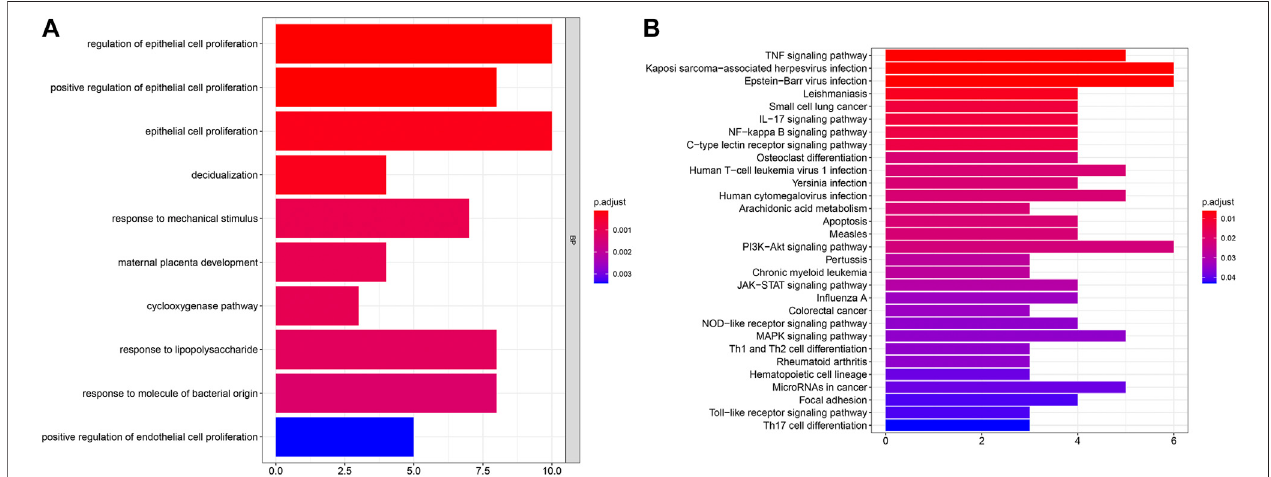
FIGURE2| GOandpathwayenrichmentanalysisofDEGs. (A) ThetoptenbiologicalprocessesofcommonDEGs.X-axisrepresentsthenumberofenrichedDEGs and y-axis represents the biological process terms. The more the color tends to red, the smaller the adjusted p-value. (B) The top 30 KEGG pathways enriched by common